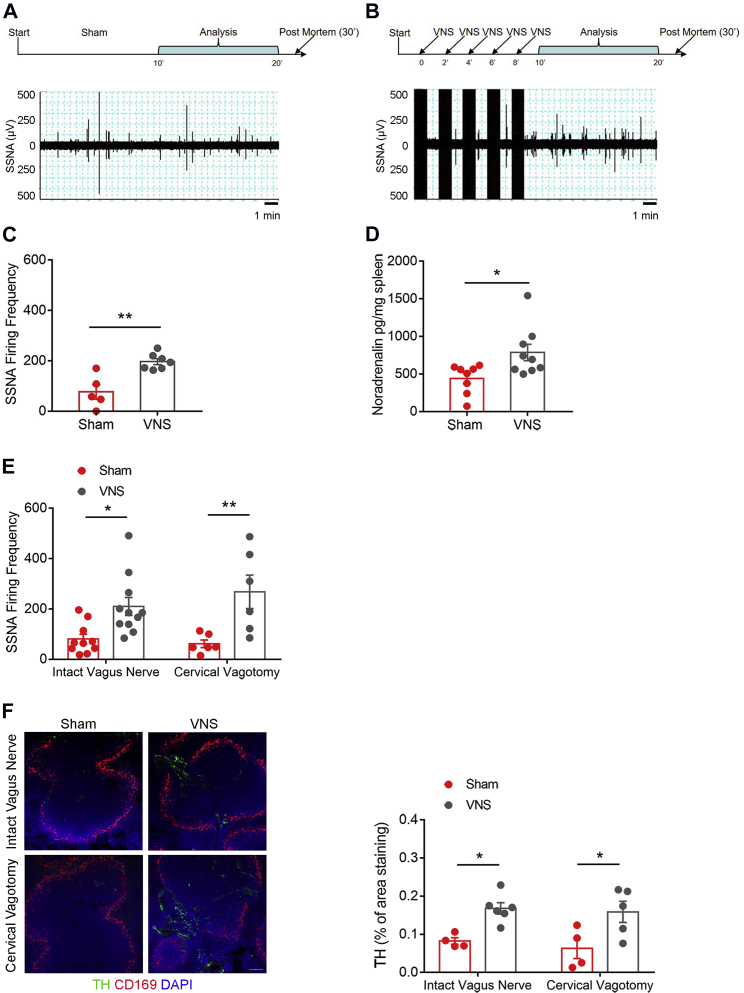
Celiac Vagus Nerve Stimulation Evokes Splenic Nerve Activity and Recruits the Splenic Adrenergic Pathway(A–C) Representative splenic nerve recordings during either sham (A) or VNS (B) procedure. As highlighted in the timelines above the recordings, sham and VNS procedures had a common time window of analysis between 10 and 20 min. VNS stimulation is performed every other minute between the starting point and 10 min. Sham-operated non-stimulated mice were subjected to the same surgical protocol, but the stimulator was kept off (see Figure S2A, related to Figure 2, for the experiment’s schematics). Mice subjected to VNS increased splenic nerve firing frequency (C) (t(10) = 4.298, ∗∗p < 0.01). Data were obtained from n = 5 sham and n = 7 VNS mice and are represented as mean ± SEM.(D) Levels of noradrenaline were assessed using ELISA in spleen homogenates and were significantly increased in mice subjected to VNS (t(15) = 2.575, ∗p < 0.05) Data were obtained from n = 8 sham and n = 9 VNS mice and are represented as mean ± SEM.(E) In order to abolish potential confounding effects of an afferent reflex vagal response, in a further experimental group, the same VNS protocol was applied in mice that were previously subjected to cervical vagus nerve resection or to the sham procedure (see Figure S2B, related to Figure 2, for the experiment’s schematics). The activity of the splenic nerve after VNS was increased both with intact cervical branch of the vagus nerve and with denervated cervical nerve (intact nerve: sham versus VNS, q(29) = 4.035, ∗p < 0.05; cervical vagotomy: sham versus VNS, q(29) = 4.877, ∗∗p < 0.01). Data were obtained from n = 10 sham intact vagus, n = 11 VNS intact vagus, n = 6 sham cervical vagotomy, and n = 6 VNS cervical vagotomy mice and are represented as mean ± SEM.(F) TH-positive staining significantly increased in the spleen of mice subjected to VNS, with both intact and resected cervical vagus nerve (intact nerve: sham versus VNS, q(15) = 4.122, ∗p < 0.05; cervical vagotomy: sham versus VNS, q(15) = 4.433, ∗p < 0.05). Data were obtained from n = 4 sham intact vagus, n = 6 VNS intact vagus, n = 4 sham cervical vagotomy, and n = 5 VNS cervical vagotomy mice and are represented as mean ± SEM (scale bar, 100 μm).